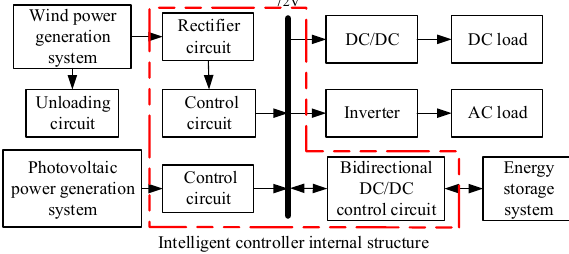
Figure 1. Overall architecture of the power supply system.